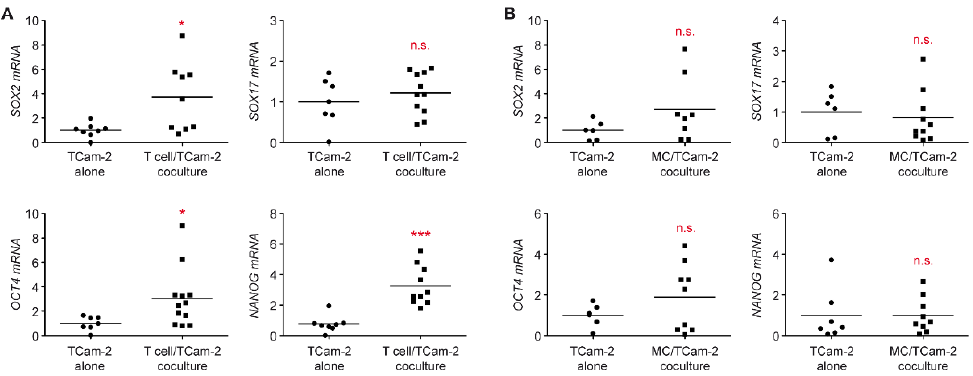
Figure 6. Analysis of gene expression of pluripotency markers in cocultures of TCam ‐ 2 cell with immune cells. T cells or monocytes (MCs) were isolated from PBMC of healthy blood donors using magnetic cell sorting and cultured in 6 ‐ well plates on a monolayer of TCam ‐ 2 cells for 24 h. TCam ‐ 2 cells cultured alone served as a control. TCam ‐ 2 cells were collected from both cultures, and RNA was prepared for subsequent analysis by quantitative RT ‐ PCR. Relative mRNA levels of SOX2 , SOX17 , OKT4, and NANOG in TCam ‐ 2 cells collected from T cell cocultures ( A ), MC cocultures ( B ), or TCam ‐ 2 cells cultured alone are depicted as dot plots with a horizontal line representing the mean. Gene expression was calculated by normalization to the housekeeping gene 18SRNA , mRNA levels in TCam ‐ 2 cells cultured alone were arbitrarily set to 1. N = 7–11; PBMC were obtained from 5–6 healthy volunteers (T cell cocultures); N = 6–10; PBMC were obtained from 4–5 healthy volunteers (MC cocultures). Statistical analysis was performed by unpaired t ‐ test (*: p < 0.05; ***: p < 0.001; n.s.: p > 0.05).